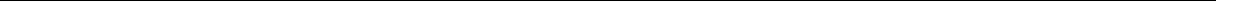
Figure 2 | b -TrCP1 binding to its degron sequence on FBXW2 and promotes FBXW2 ubiquitylation. ( a ) b -TrCP1 has no effects on FBXW2 binding mutant: H1299 cells were transfected with indicated plasmids, switched 48h later to fresh medium containing CHX and harvested at indicated periods for IB. The band density was quantified. ( b ) Loss of b -TrCP1-FBXW2 binding in degron site mutant: FBXW2 or its 3A mutant at the degron site was co-transfected with HA- b -TrCP1, followed by IP with FLAG Ab and IB. ( c ) b -TrCP1 shortens the protein half-life of FBXW2, triggered by serum addition to serum-starved (SS) cells: H1299 cells were transfected with indicated plasmids, switched 48h later to fresh medium containing10% FBS (fetal bovine serum) and CHX and harvested at indicated periods for IB. The band density was quantified. ( d , e ) CK1 kinase mediates FBXW2 phosphorylation at b -TrCP1 binding motif: H1299 cells were transfected of siRNA targeting GRK2, or treated by CK1 inhibitor IC-261 (10 m M) ( d ), or transfected with siRNA targeting VRK2 ( e ), followed by transfected with FLAG- b -TrCP1 for 48h. Cells were harvested at indicated points after CHX treatment for IB. The band density was quantified. ( f , g ) b -TrCP1 promotes FBXW2 ubiquitylation in vivo : 293 ( f ) or H1299 ( g ) cells were transfected with indicated plasmids, lysed under denatured condition at 6M guanidinium solution, followed by Ni-beads pull-down. Washed beads were boiled for IB to detect polyubiquitylation of exogenous FBXW2 ( f ) or endogenous FBXW2 ( g ). ( h ) b -TrCP1 promotes FBXW2 ubiquitylation in vitro : b -TrCP1 (E3) was prepared by transfecting HA- b -TrCP1 or HA- b -TrCP1 D F into 293 cells, followed by HA-bead IP and 3 (cid:2) 3 HA peptide elution. FBXW2 and FBXW2 mutant were prepared by transfecting FLAG-FBXW2 or FLAG-FBXW2-3A into 293 cells, followed by FLAG-bead IP. b -TrCP1 (E3) and FBXW2 (substrate) were added into a reaction mixture containing ATP, ubiquitin, E1 and E2, followed by constant mixing for 60min. The reaction mixture was then loaded onto PAGE gel for IB using anti-FLAG Ab. ( i ) b -TrCP1 promotes FBXW2 ubiquitylation via K48 linkage: H1299 cells were transfected with indicated plasmids, lysed under denatured condition at 6M guanidinium solution, followed by Ni-beads pull-down and IB for